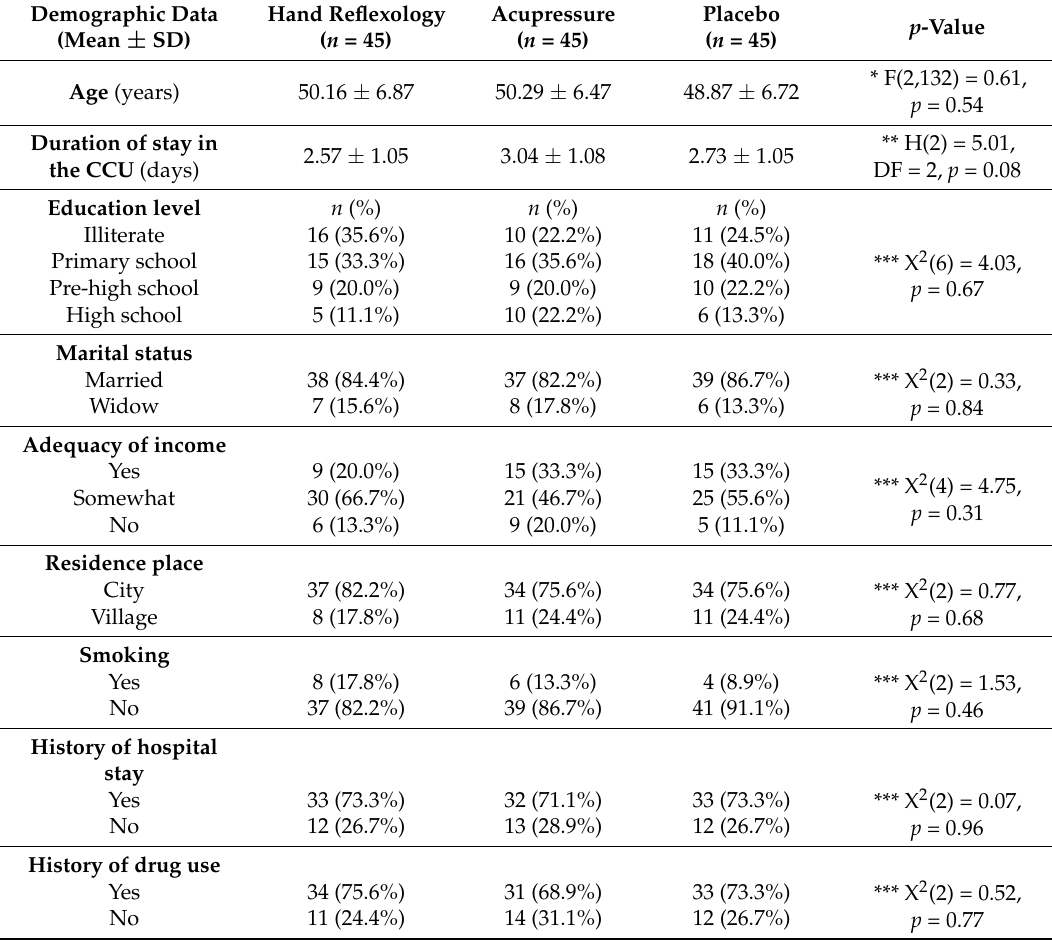
Table 1. Comparison of demographic characteristics between the